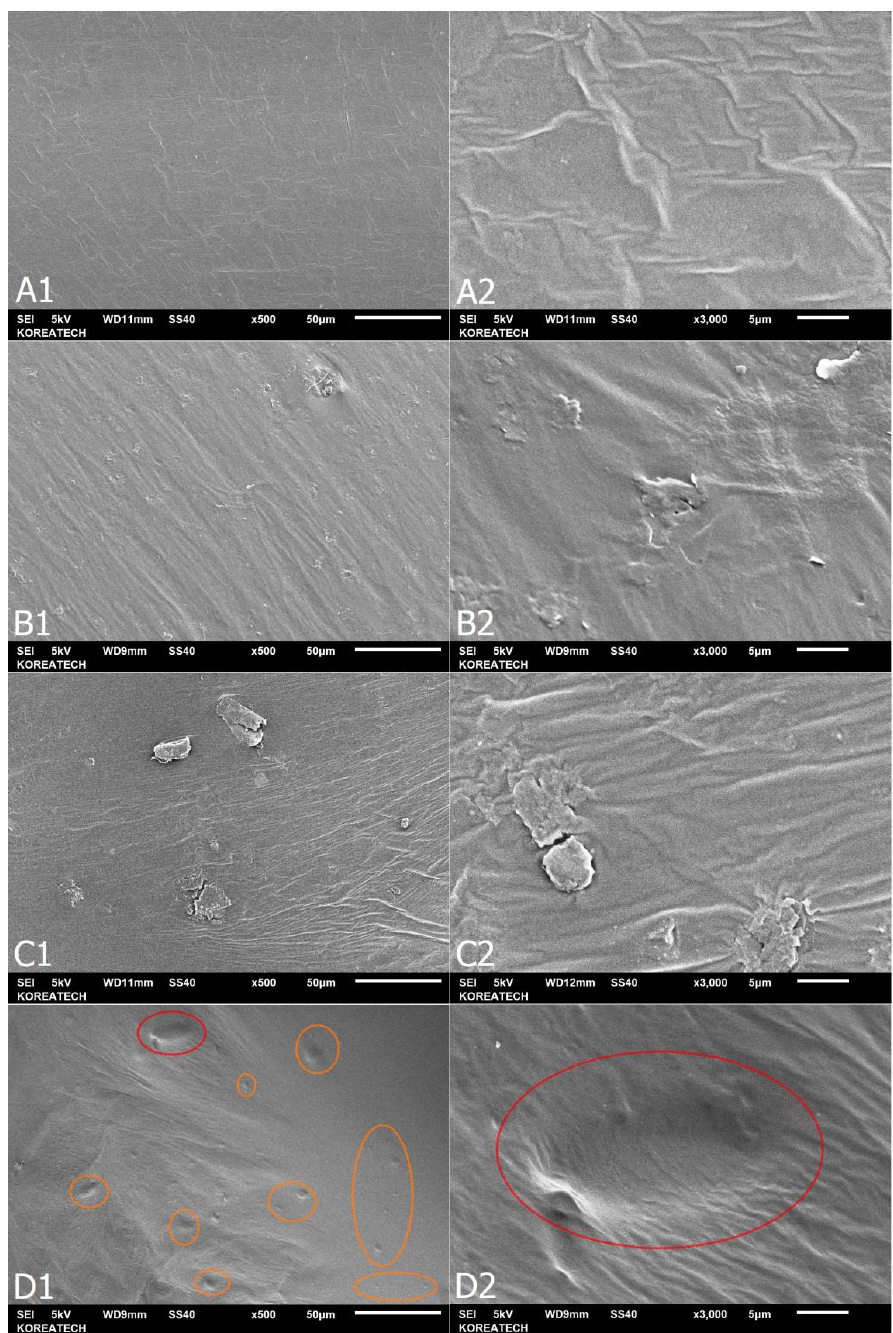
Figure 12. Scanning electron microscope (SEM) micrographs of unfilled and OSP-filled asphalts taken at × 500 [denoted with number 1] and × 3000 [denoted with number 2] magnifications. ( A ) AP-5